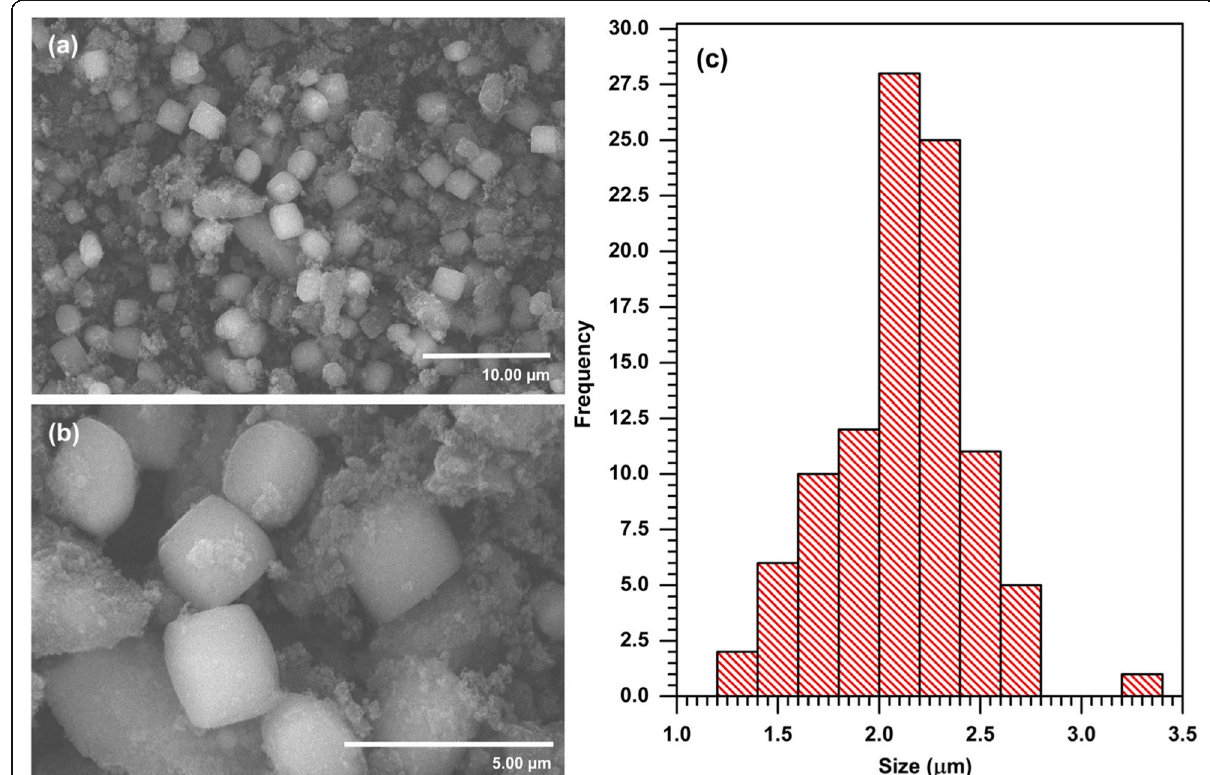
Fig. 3 Micrograph ( a, b ) and particle size distribution ( c ) of ZSM-5